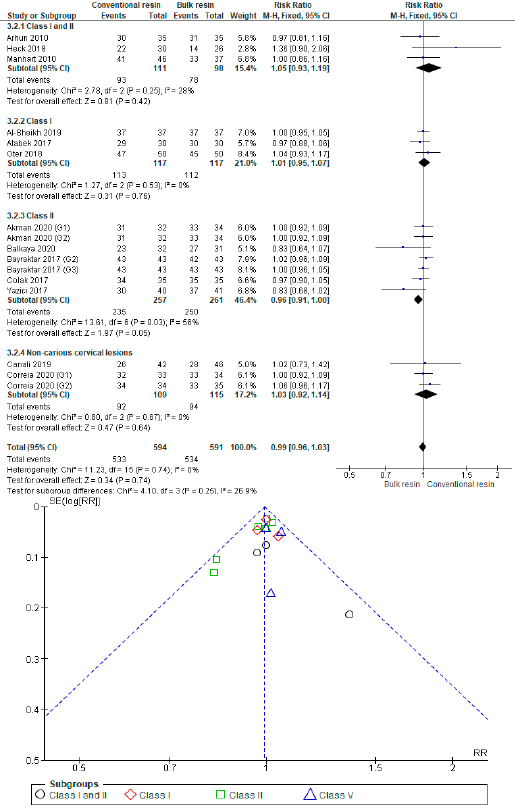
Figure A12. Adequate Marginal Adaptation: Conventional Resin versus Bulk Resin According to Type of Restoration.